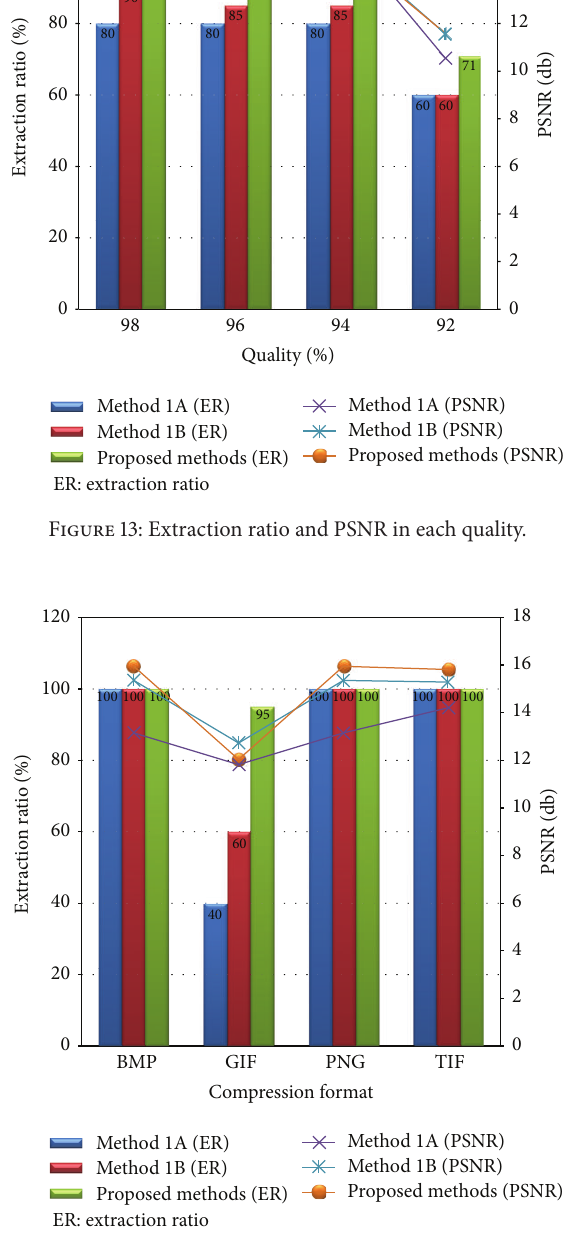
Figure 14: Extraction ratio and PSNR in compression format.